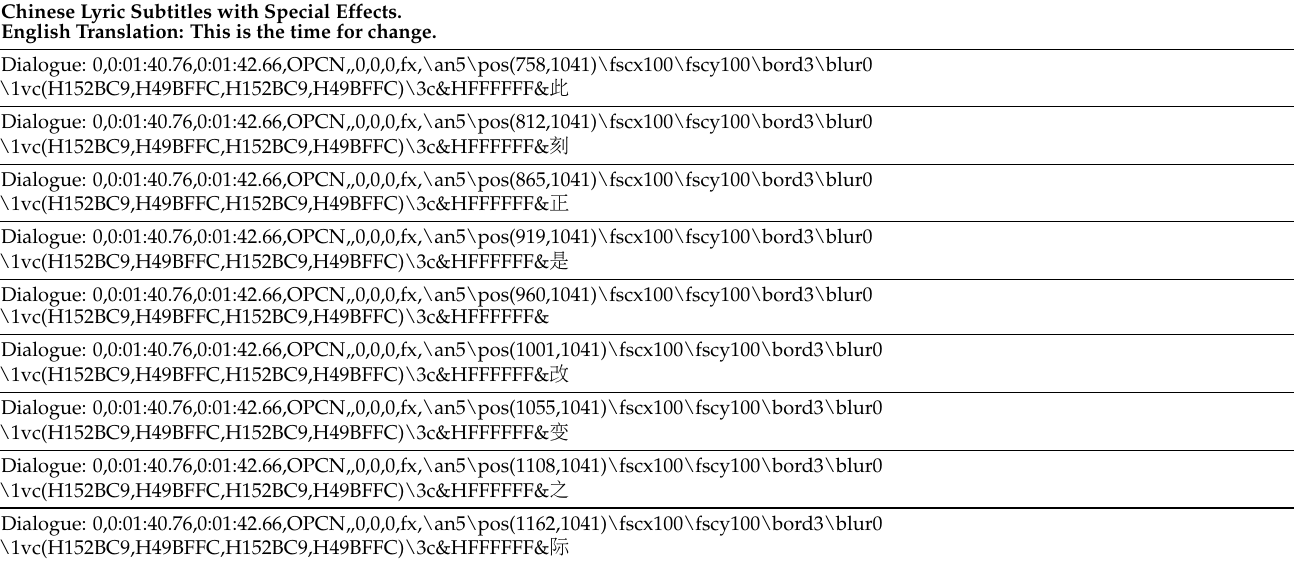
Table 2. Examples of special effects lyric